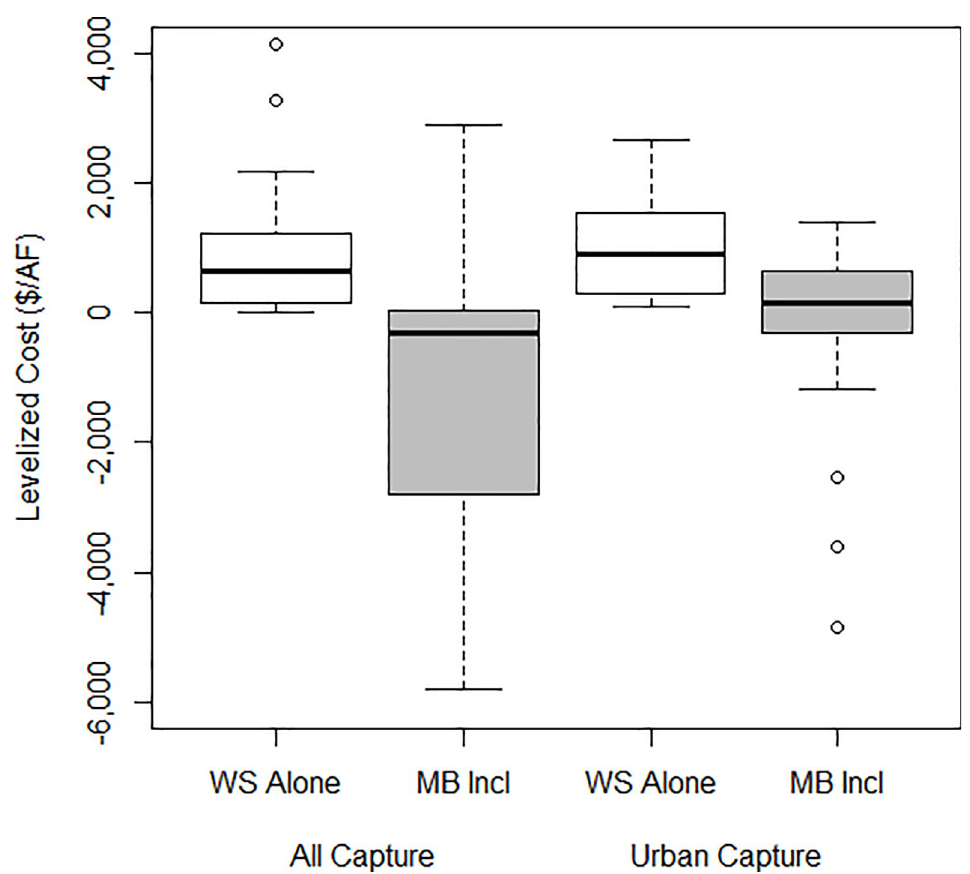
Fig 6. Boxplot of levelized cost of when including water supply (WS) alone in $ per AF (white), compared to net levelized cost incorporating multiple benefits (MB) in $ per AF (grey) for all stormwater capture projects (left) and urban stormwater capture projects